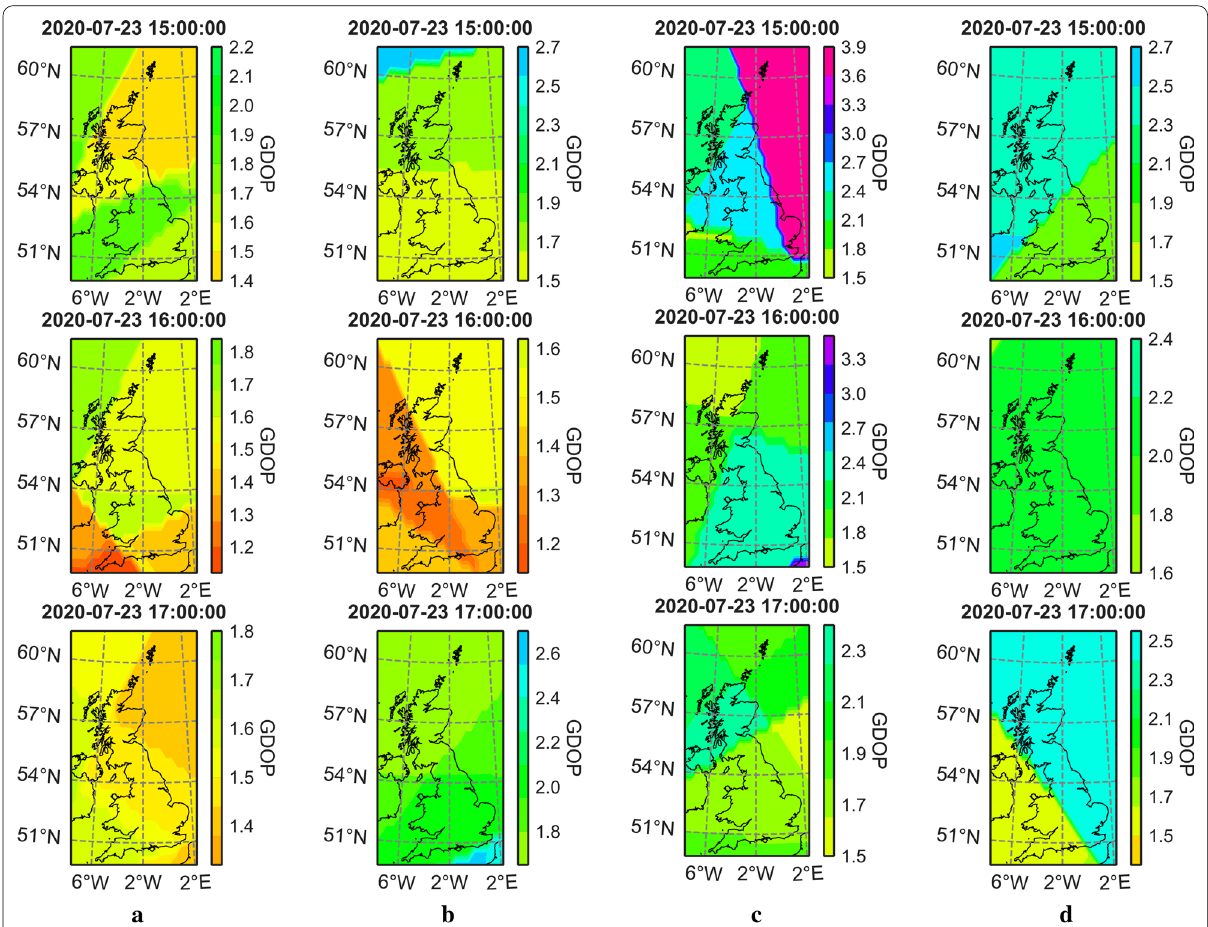
Fig. 5 GDOP distribution of satellites for a BDS, b GPS, c Galileo and d GLONASS at three moments in the UK territory